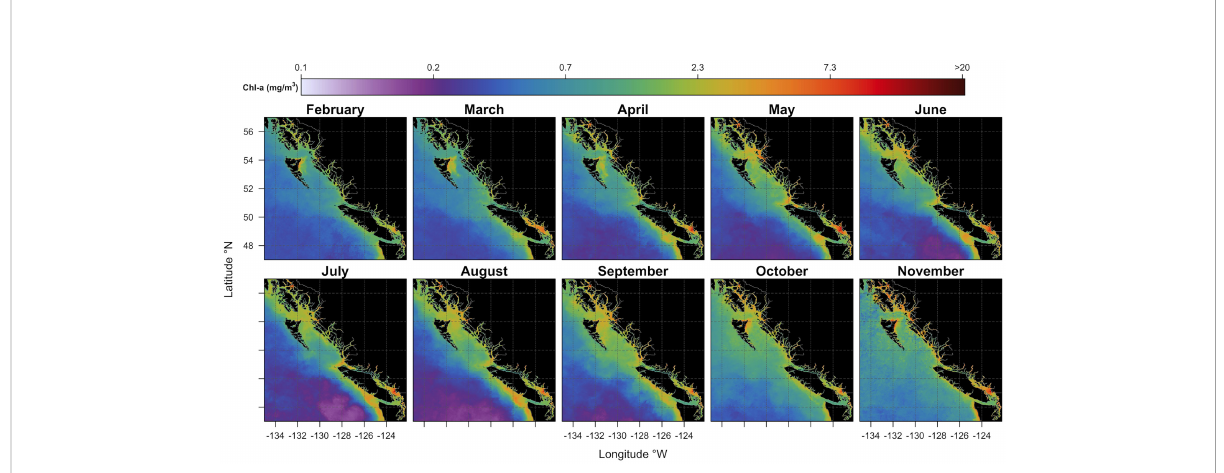
FIGURE 4 Monthly climatological (mean 2016-2020) maps of chlorophyll-a concentration expressed in mg/m 3 (see the colored bar on the top). Black areas denote the